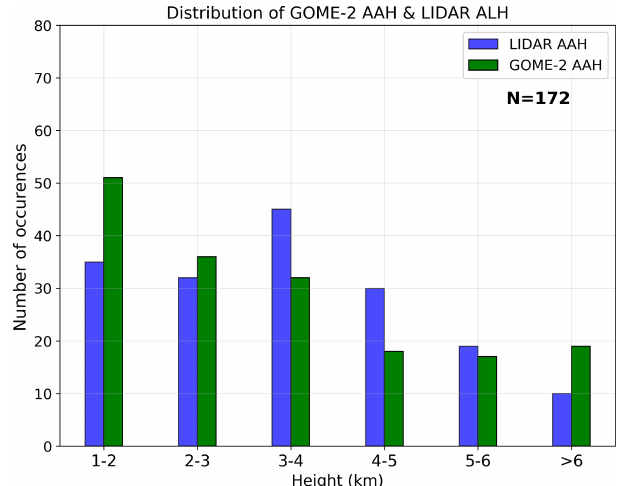
Figure 8. Bar plot of GOME-2 AAH (green) and EARLINET ALH (blue) station occurrences. The height ranges of bins are between